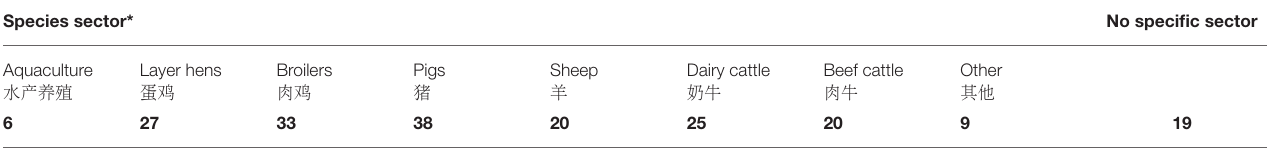
TABLE 1 | Research participants ( n = 100) by sector. Species sector*